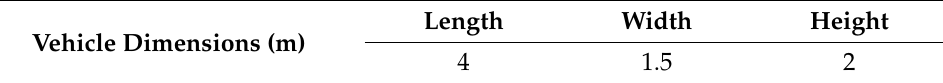
Table 1. Vehicle dimensions in